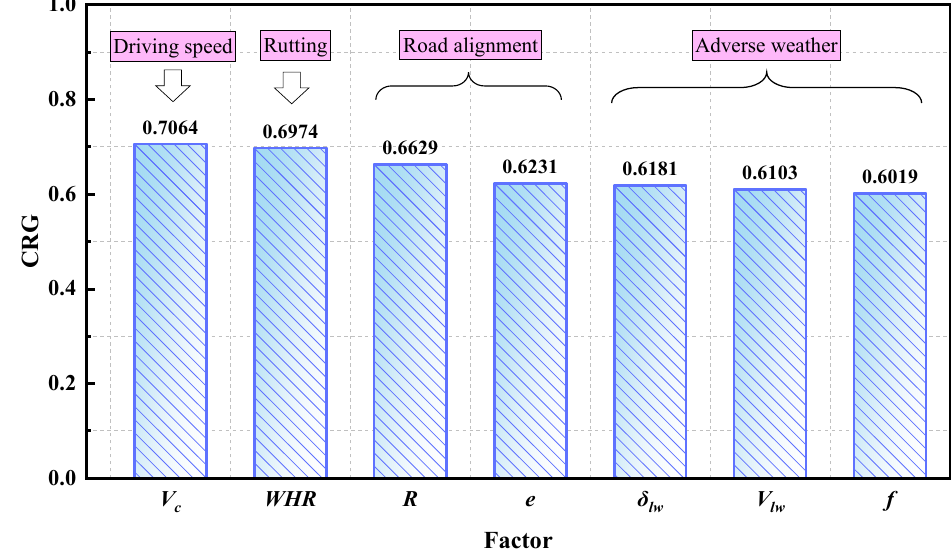
Figure 14. The impact of driving speed, rutting, road alignment, and adverse weather on CRG.